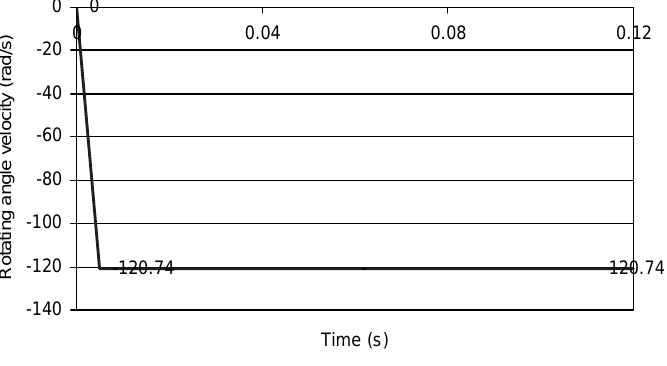
Fig. 2. Rotation-angular velocity imposed at the center of driving sprocket.